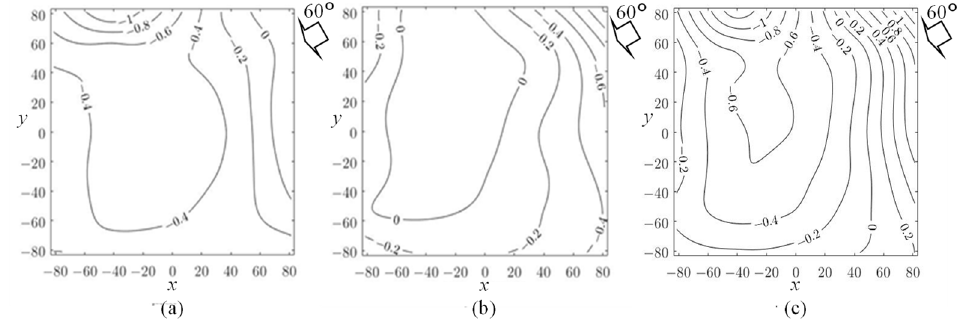
Figure 7. Contours of mean wind pressure and force coefficients at θ = 60 ◦ : ( a ) C pt , ( b ) C pb , ( c ) C f .